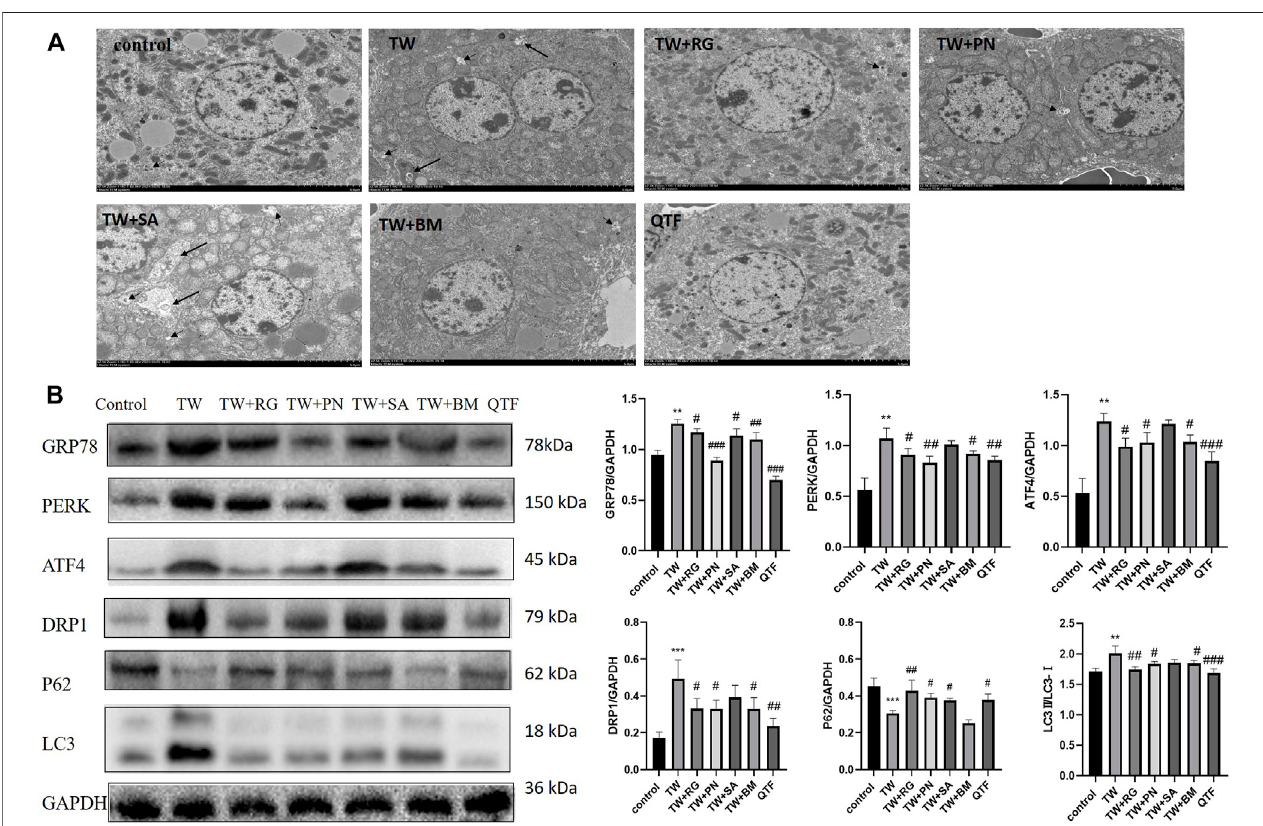
FIGURE4 | QTF attenuatedTW-induced excessivemitophagyand ERS in C57BL/6J mice. (A) QTF improved mitochondrial and ERdamage induced by TW,and reducedautophagosomes and autophagolysosomes.The small black arrow representsautophagosomes, and thelarge black arrow representsautophagolysosomes. 2,500 magni fi cation, Scale bar: 5 µm. (B) QTF reversed the TW-induced expression level of GRP78, PERK, ATF4, DRP1, P62 and LC3. Compared with the control group, *p < 0.05, **p < 0.01, ***p < 0.001 ; compared with the TW group, # p < 0.05, ## p < 0.01, ### p <